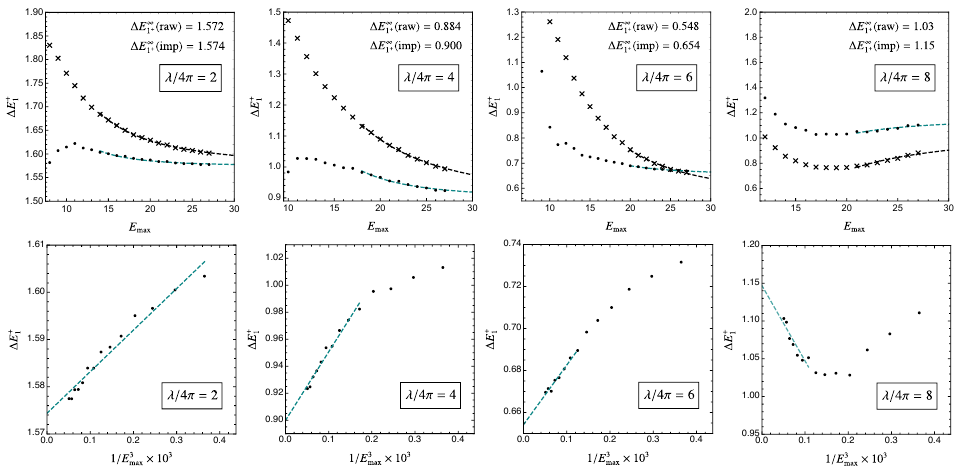
Fig. 8. The (cid:90) -even ground state excitation energy ∆ E + dependence on the energy 2 1 = 1 and 2 π R = 10. The high cutoff E for λ/ 4 π = 2,4,6,8. In all panels, m max NO E tails of ∆ E + for the raw and improved theories are fit to 1 / E 2 and 1 / E 3 , max max max 1 respectively. The agreement between the asymptotic values of the raw and improved theories degrades for larger couplings. In the bottom panels, we see that the im- proved result maintains 1 / E 3 scaling to good approximation for strong max